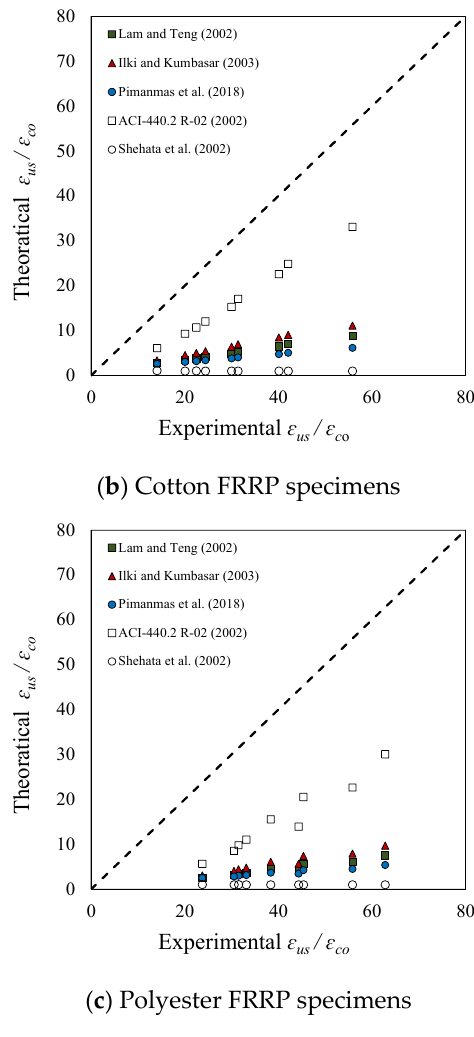
Figure 15. Assessment of strain models.